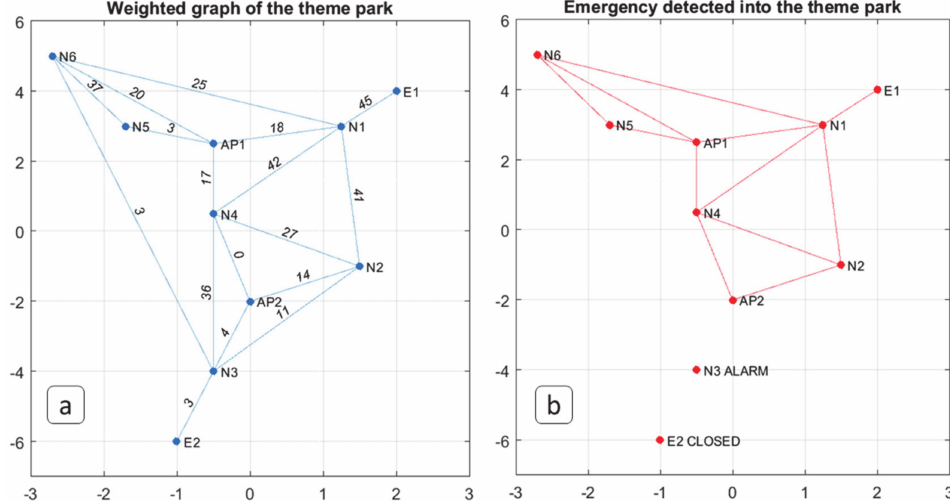
Figure 13. Example of the results of the Algorithm 3 in case of an environmental / structural alarm at node 3 (N3), where ( a ) is the graph before the alarm triggering and ( b ) is the graph after the alarm